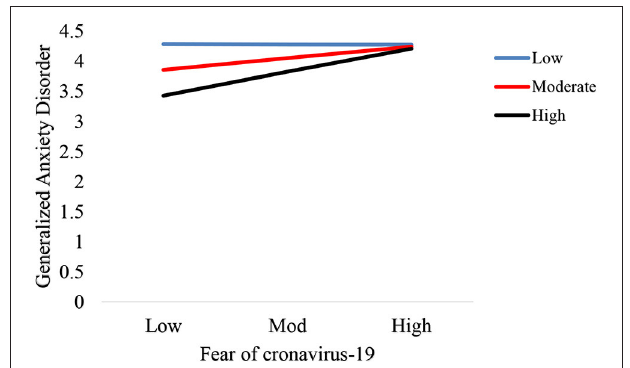
recommended the estimates for NFI and CFI to be above 0.8 for a good fit.